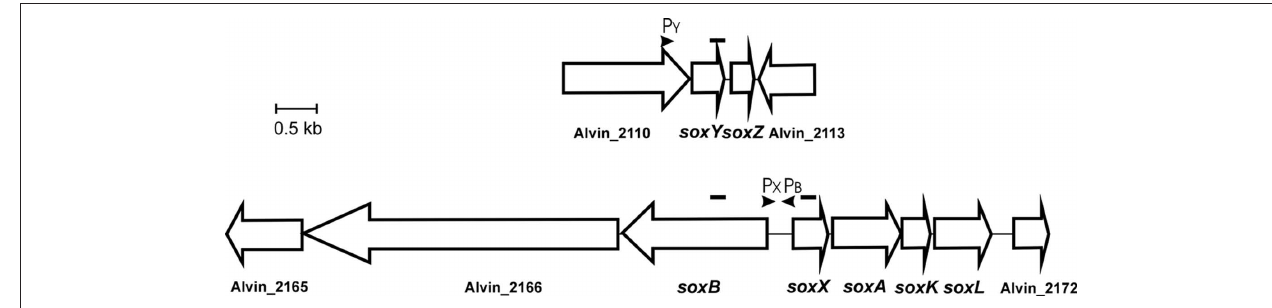
FiGurE 1 | Schematic overview of the two sox gene loci in A. vinosum . The location of potential promoters for soxB, soxX, and soxY is indicated. Amplicons generated for RT-PCR are indicated by black bars above the genes.